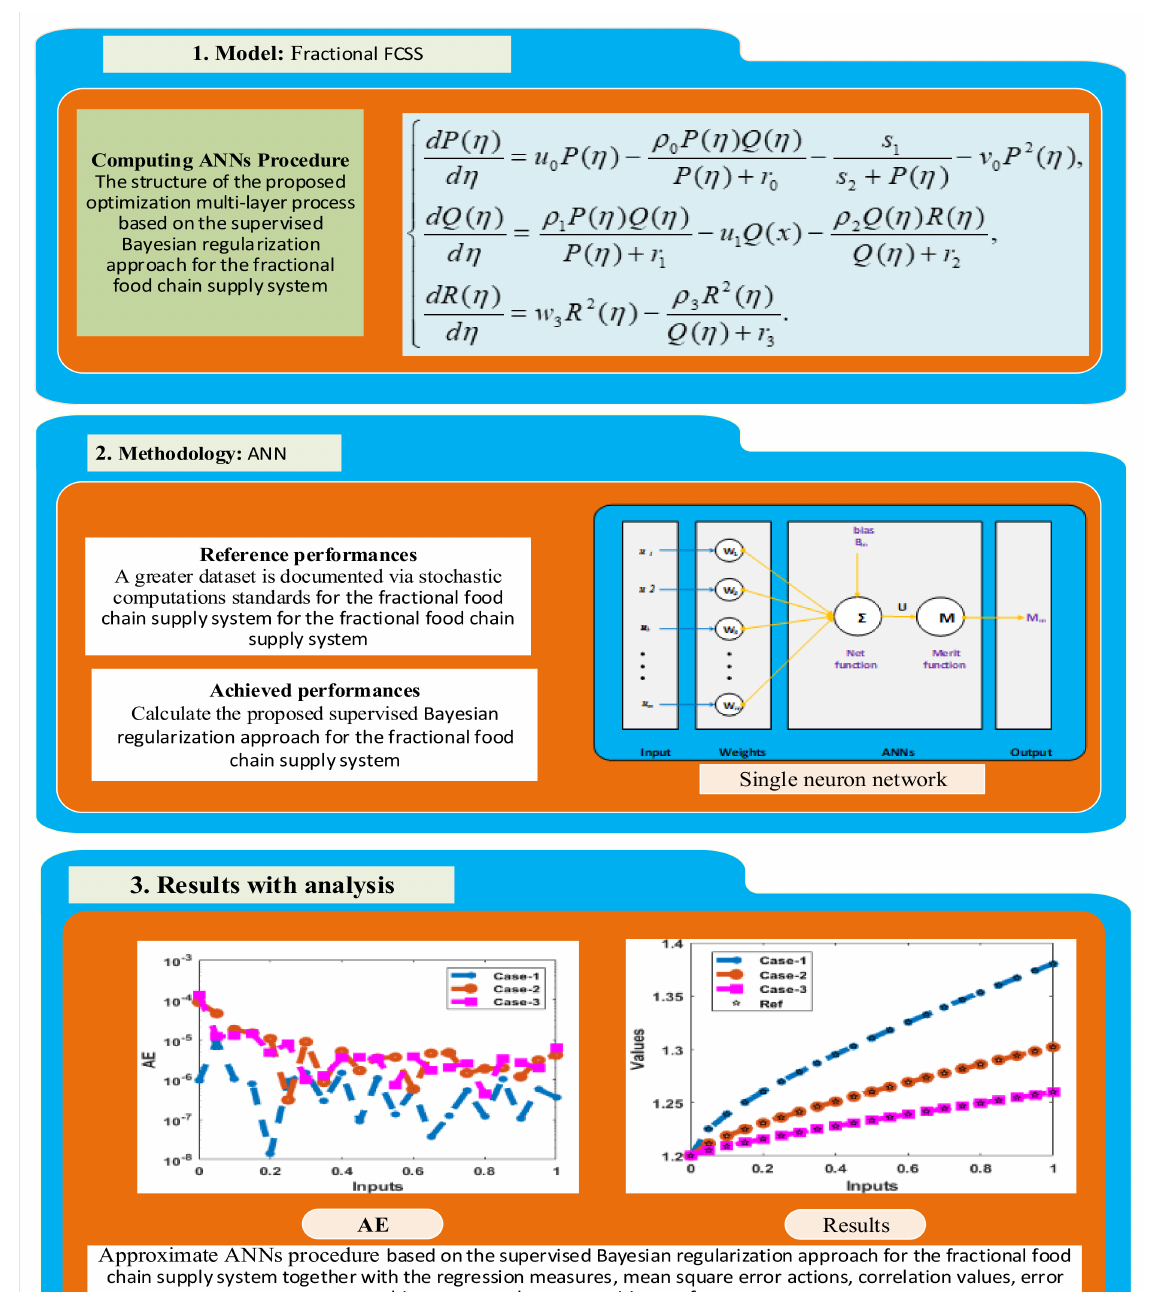
Figure 1. Mathematical model, ANN procedures, and result performances of the dynamical